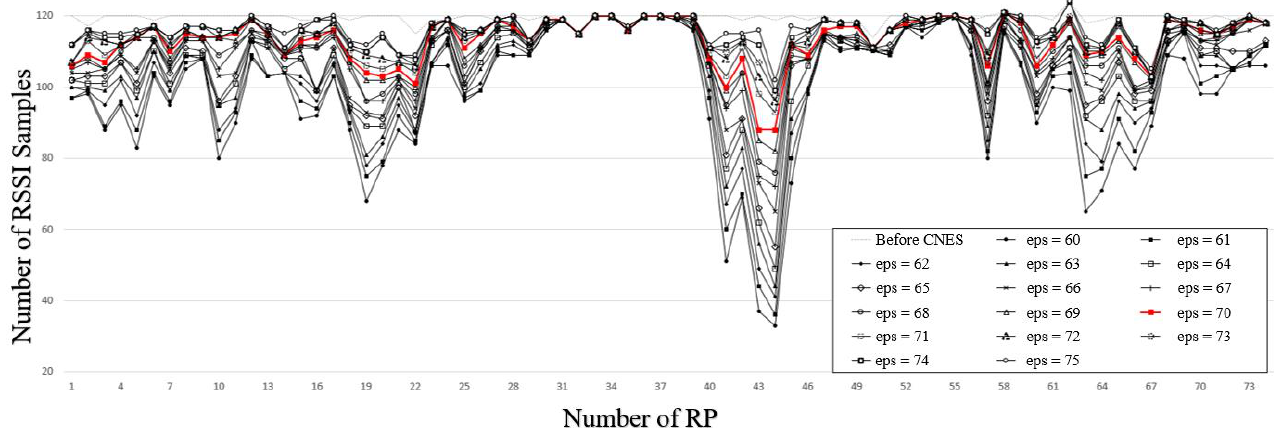
Figure 12. The effect of CNES on the number of RSSI samples at each RP corresponding to different eps values.